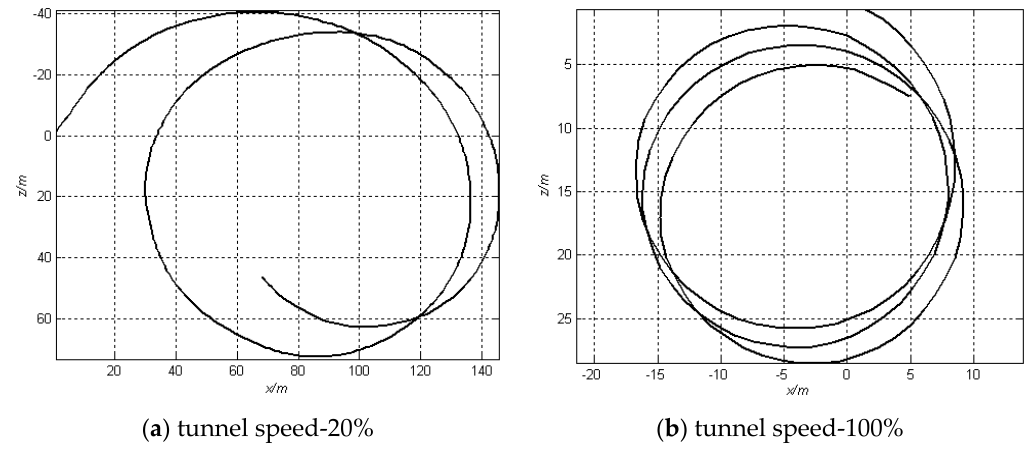
Figure 27. Turning Figure 27. Turning experiment.